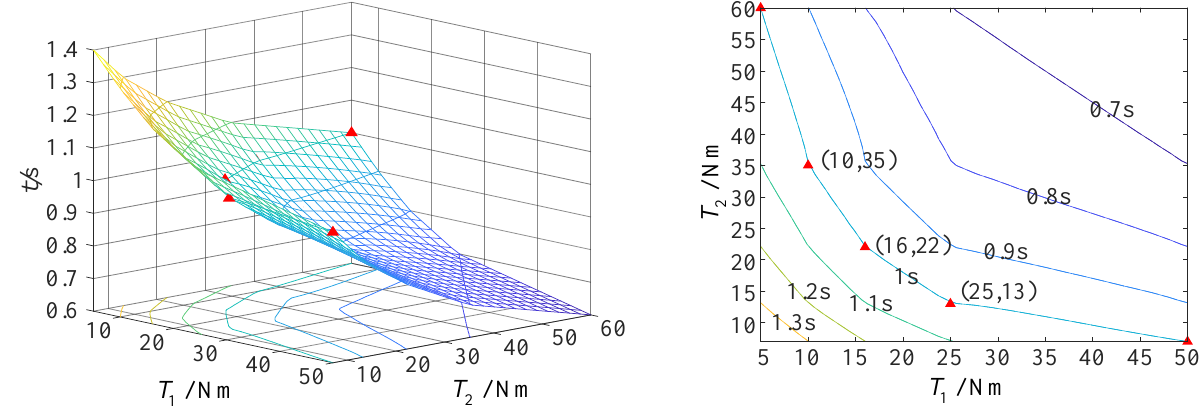
Figure 16. The curve of driving torque and deployment time of folding wing at an airspeed of 10 m/s (non-fixed-axis–fixed-axis stepwise deployment mode).